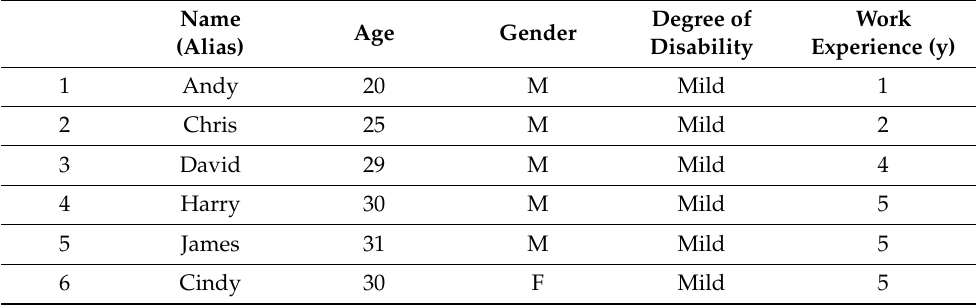
Table 1. Information about Interview